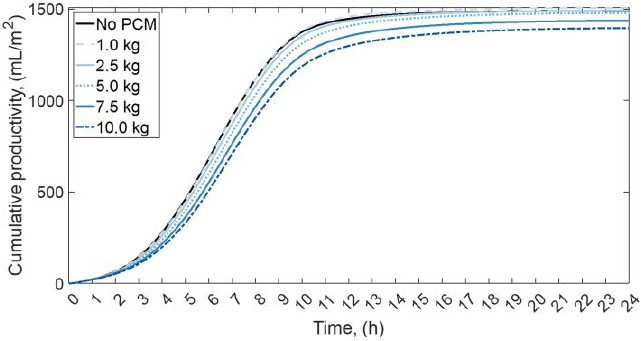
Figure 22. The cumulative productivity of the SS with different masses of PCM — Case 4. Table 8. The productivity of the SS with and without PCM for different cases. Case